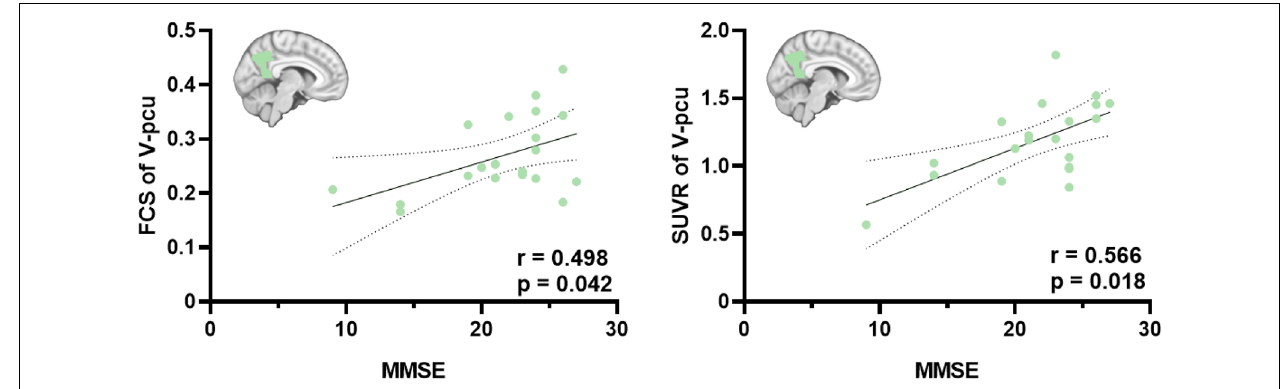
FIGURE 4 | Significant correlations between FCS and MMSE scores and between SUVR and MMSE scores in the V_pcu of AD patients. Partial Pearson’s correlations were performed with age, gender and education were considered as covariates. Abbreviations: FSC, functional connectivity strength; SUVR, standard uptake value ratio; AD, Alzheimer’s Disease; V_pcu, ventral precuneus; MMSE, Mini-Mental State Examination.